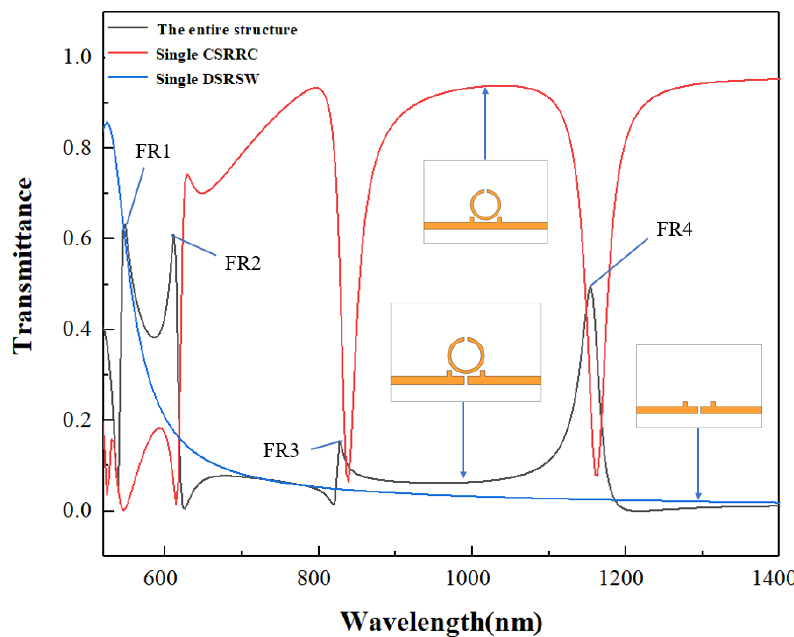
Figure 2. Transmission spectra of the single DSRSW (blue line), the single CSRRC (red line), and the entire structure (black line).